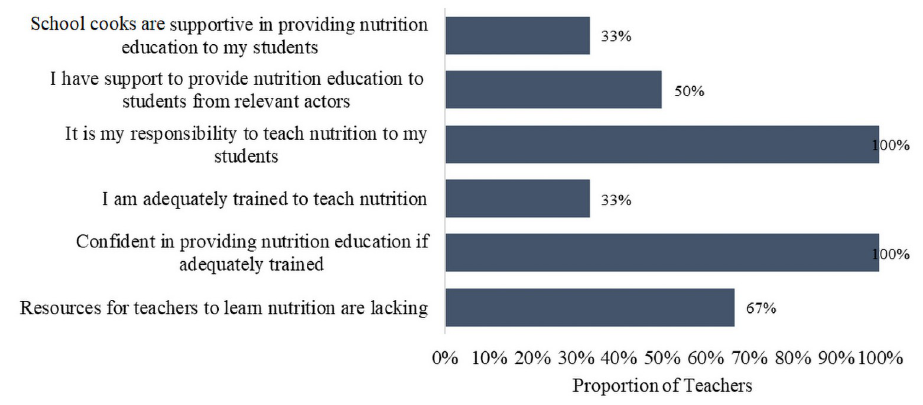
Fig 2. Teachers’ feedback on providing nutrition education at their schools (n =